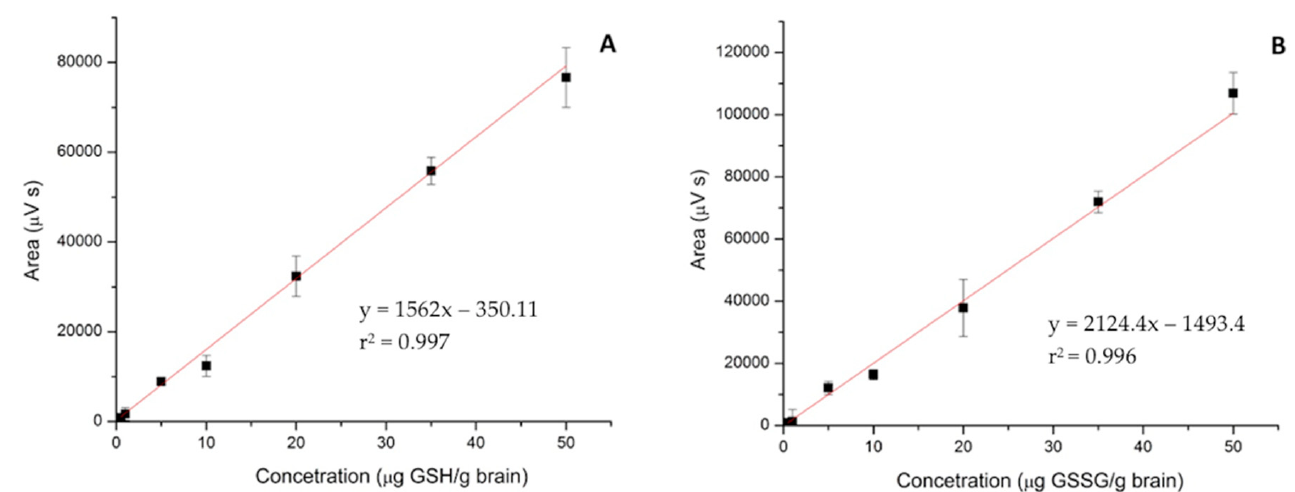
Figure 2. Analytical curves for reduced (GSH) ( A ) and oxidized glutathione (GSSG) ( B ) in the range 0.50–50 µg/g brain.